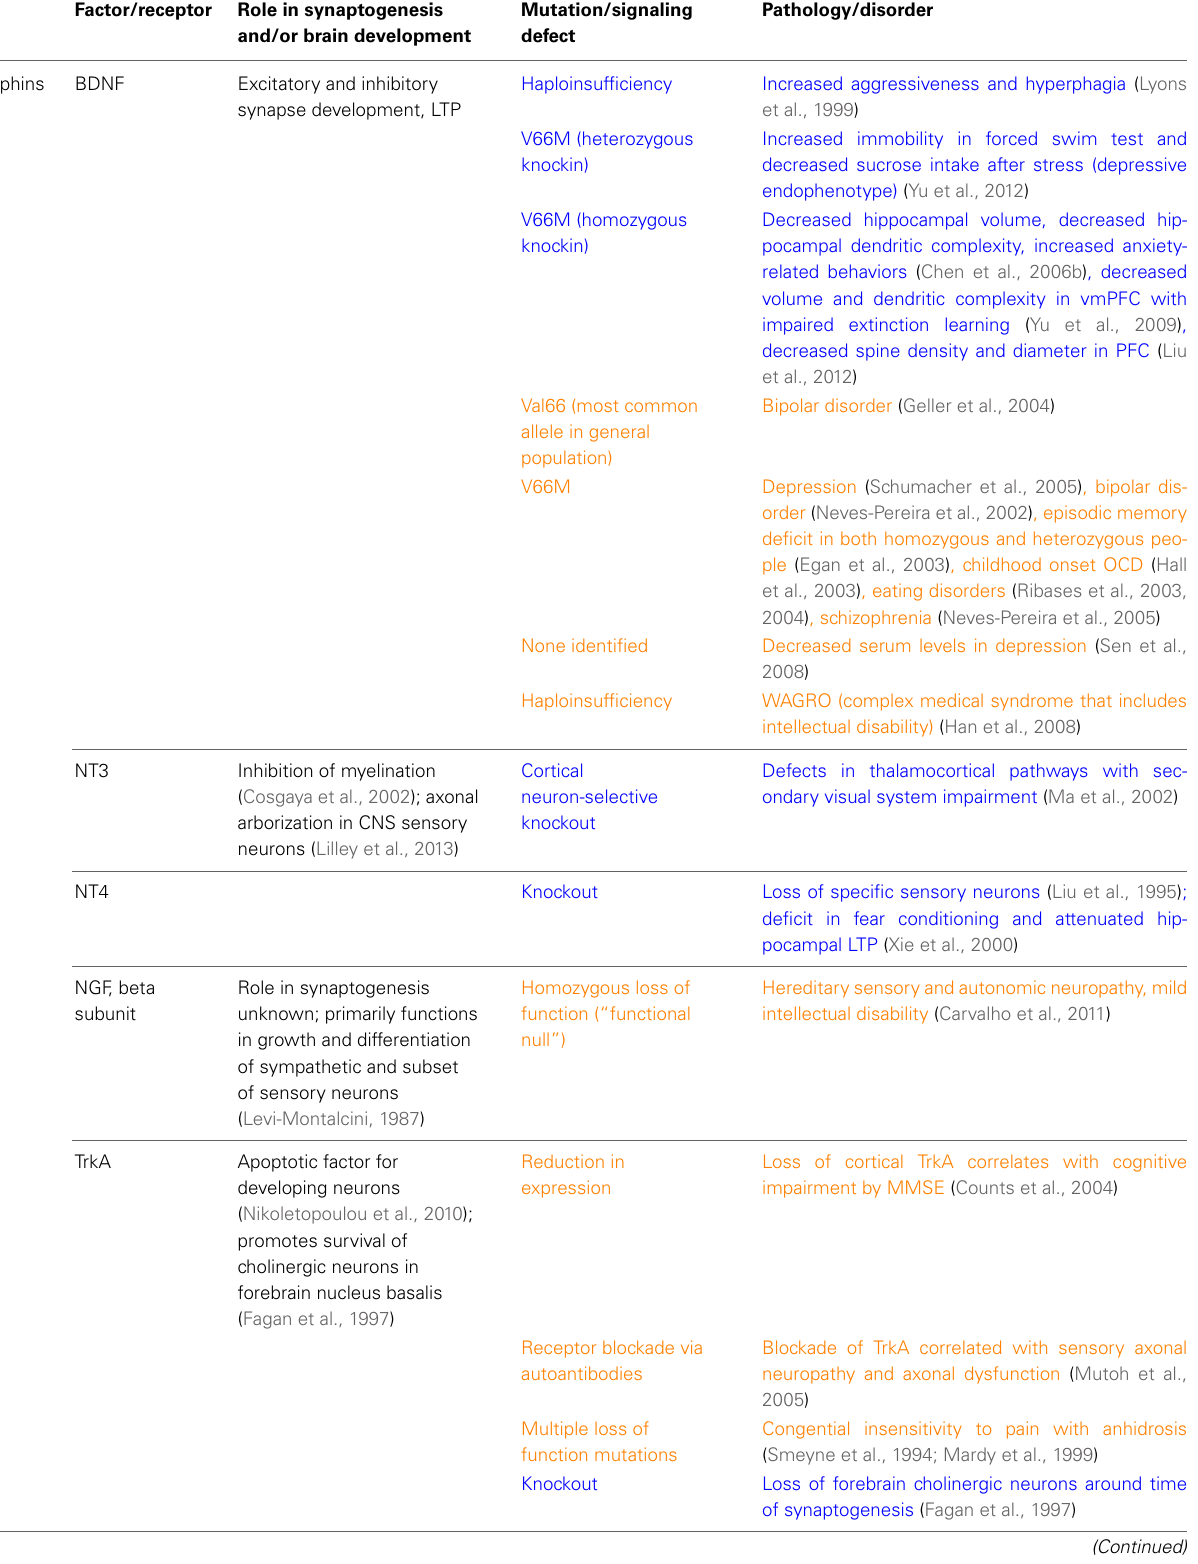
Table 1 | Growth factors and their receptors in synaptogenesis and neuropsychiatric disease.